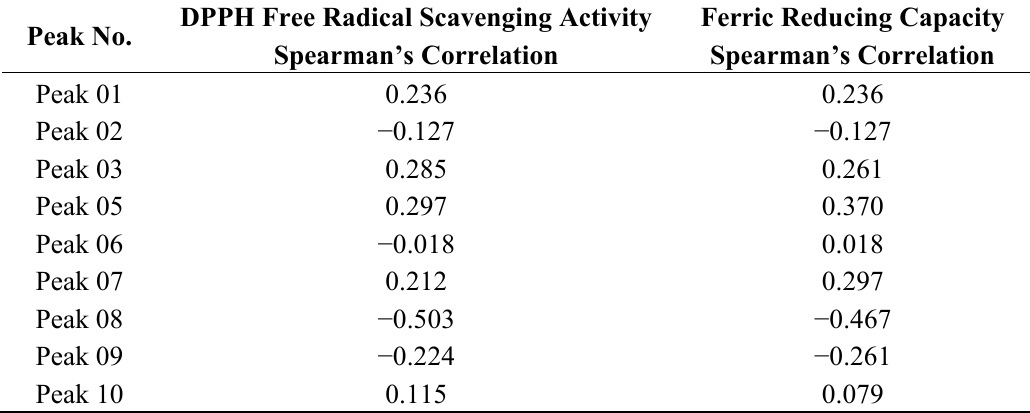
Table 6. Spearman’s correlation between the characteristic peaks of each AH sample and its antioxidant